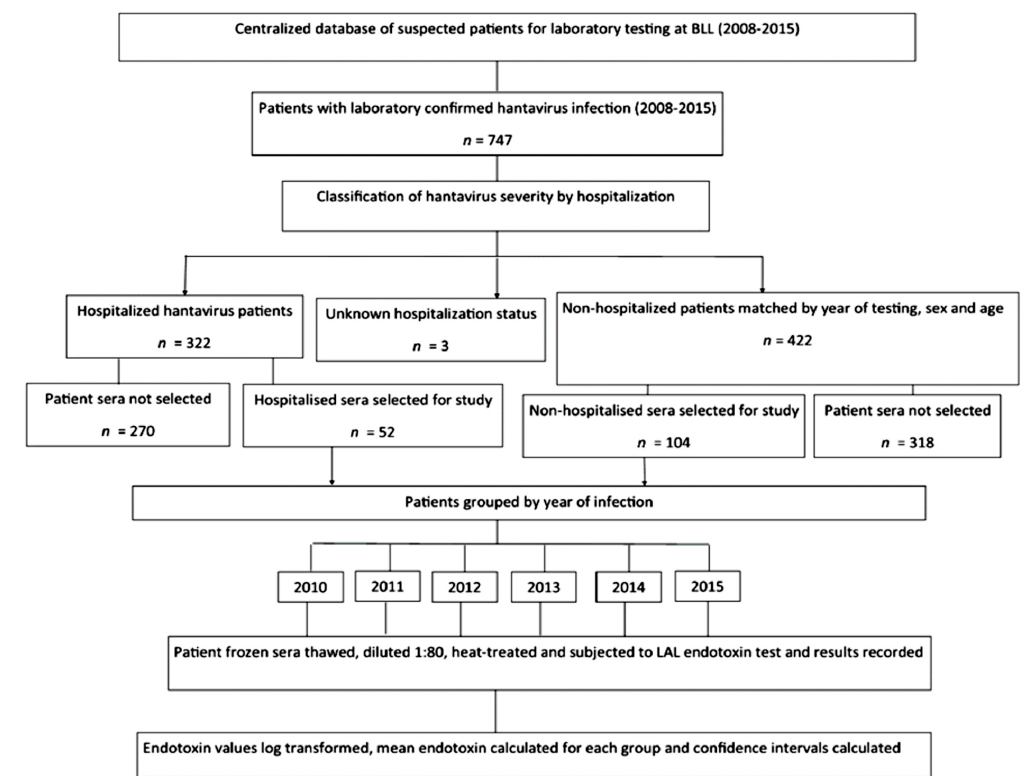
Figure 1. Flow chart of the investigation of serum endotoxin and hantavirus disease severity.